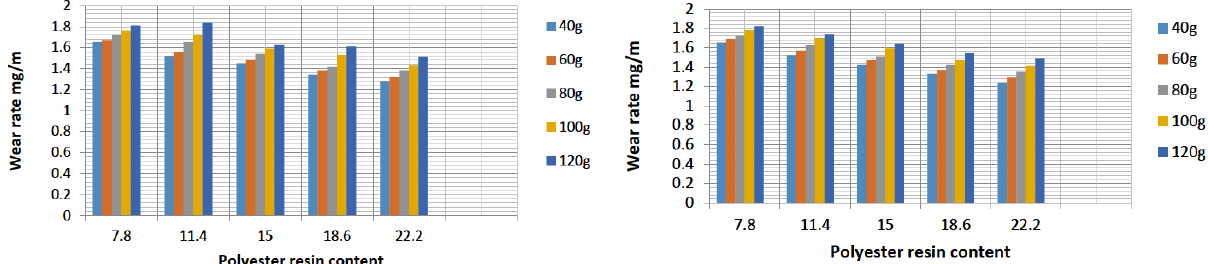
Figure 13: Wear rate of CNS /Polyester 420 µ m at 50 ∘ C